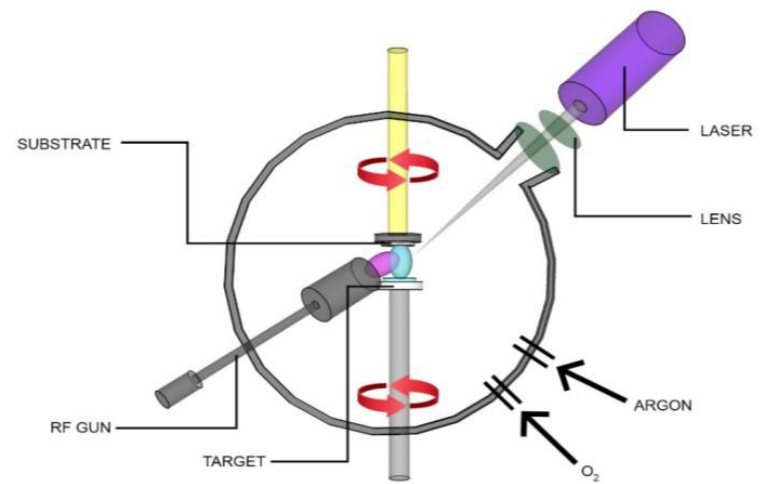
Figure 1. Schematic diagram of the PLD and RFMS hybrid System.